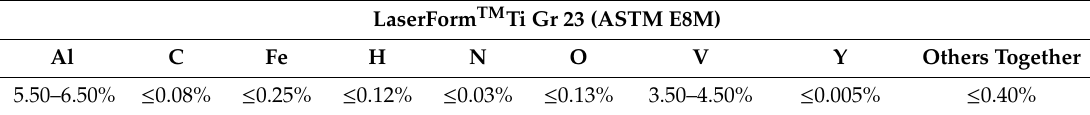
Table 1. The chemical composition of the powder used to samples production [45].